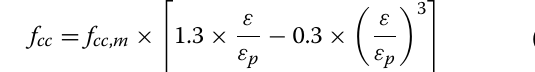
specimens.(See figure on next Fig. 8 Crack developent and failure pattern of compressive